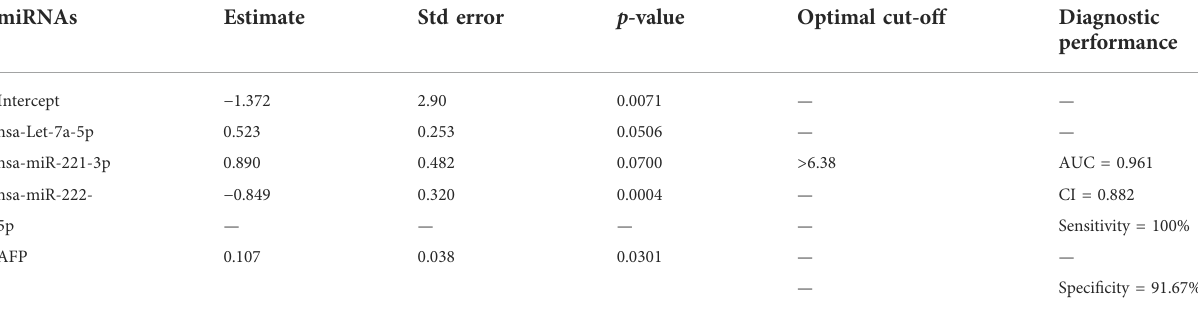
TABLE 4 Stepwise logistic regression analysis of candidate miRNAs in combination with AFP. The statistical analysis was done using GraphPad Prism 5.0.